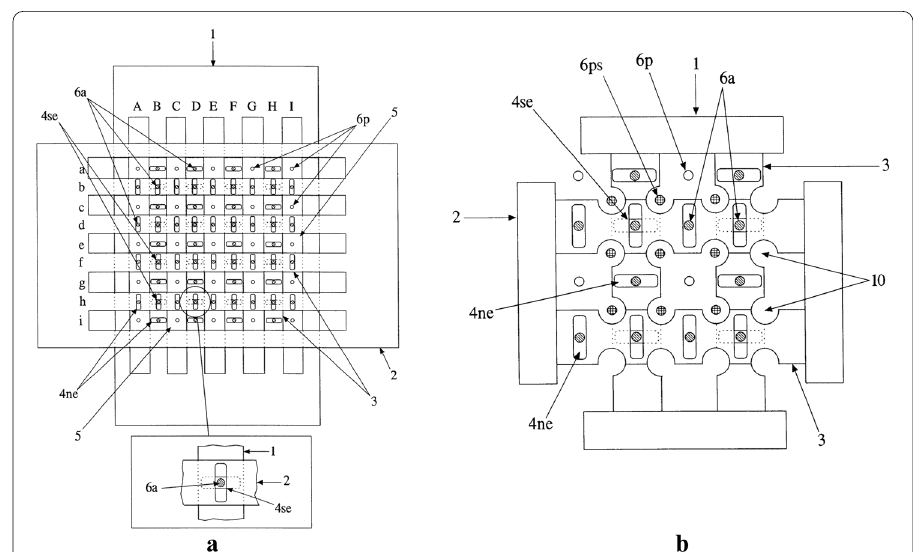
Fig. 4 Linear–linear method (Khokar 2002b). a General construction of heald wires, b modified heald wires. 1,2—heald frames, 3—heald wires, 4ne—heald eye, 4se—superimposed heald eyes, 5—openings,